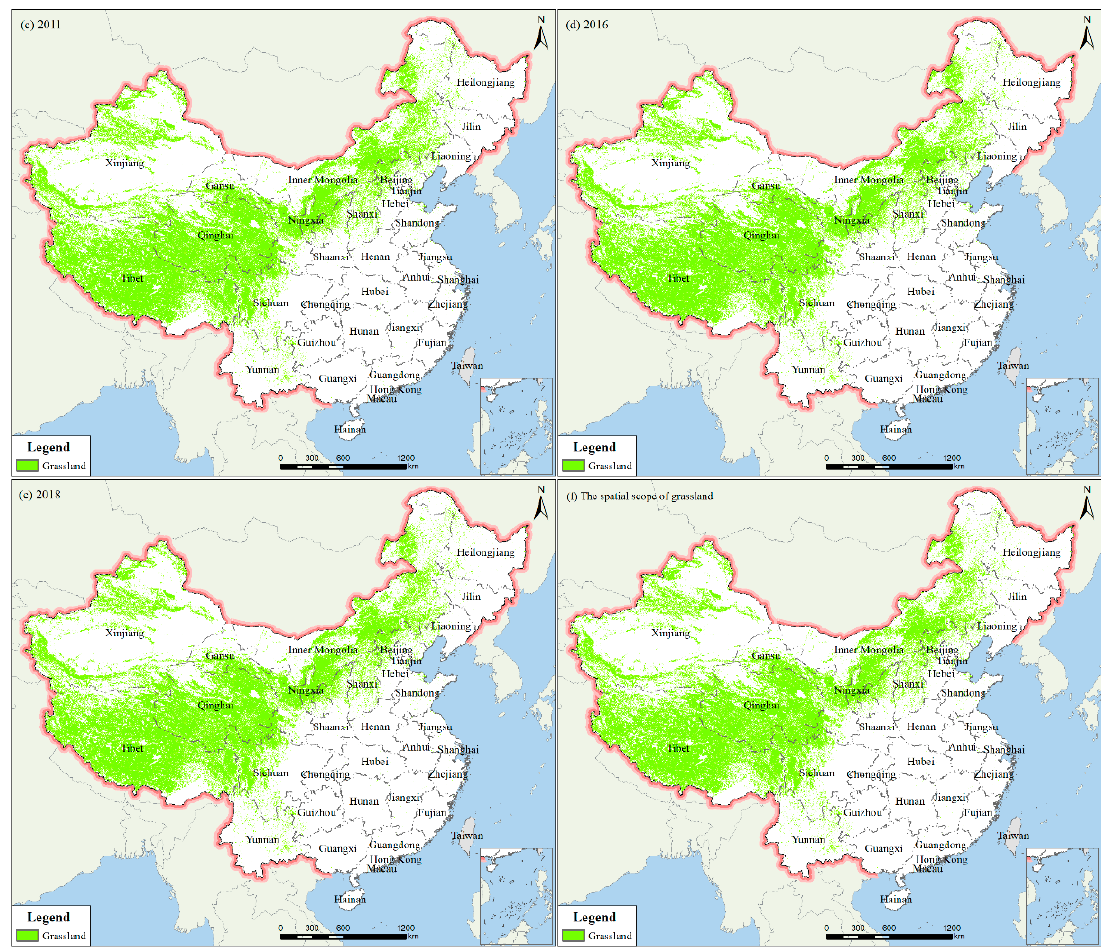
Figure 4. The spatial scope of grasslands in China.